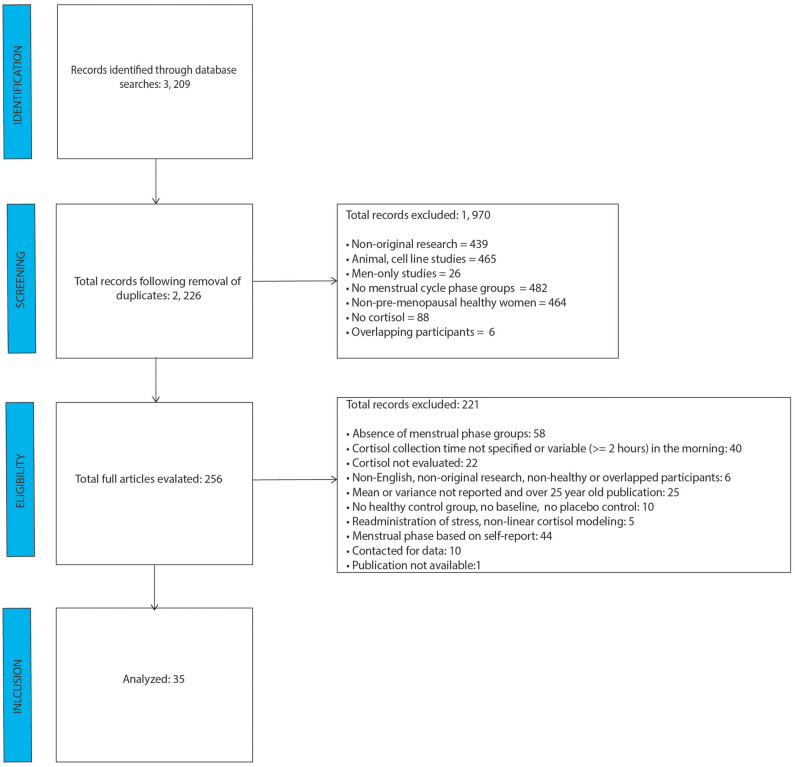
PRISMA flow diagram.